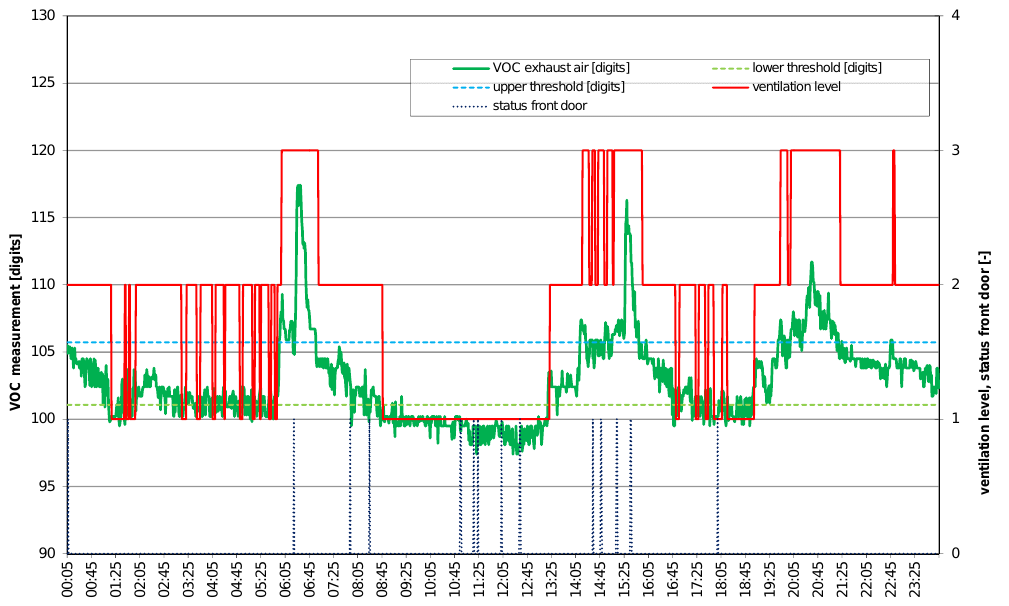
Figure 11. Example daily profile of VOC concentration in exhaust air, ventilation mode.